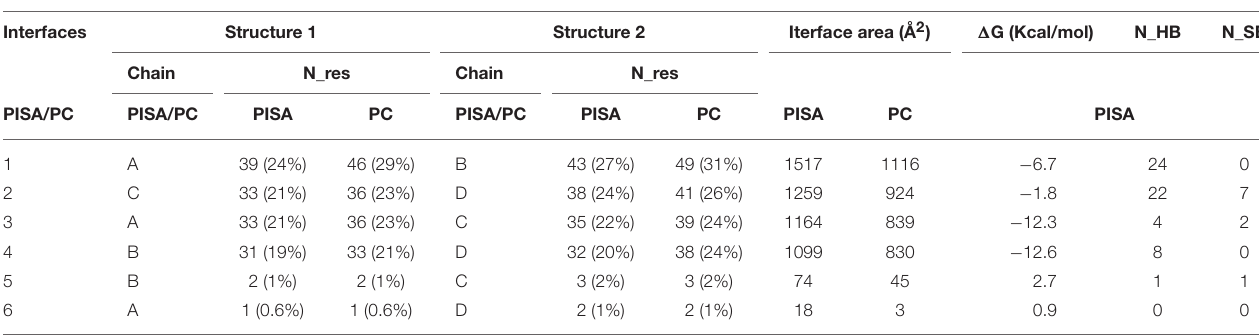
TABLE 3 | Interfaces analysis of